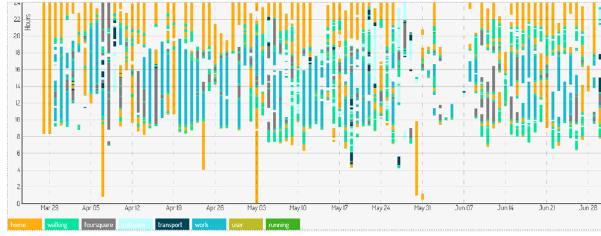
Figure 4 A timeline view of daily events